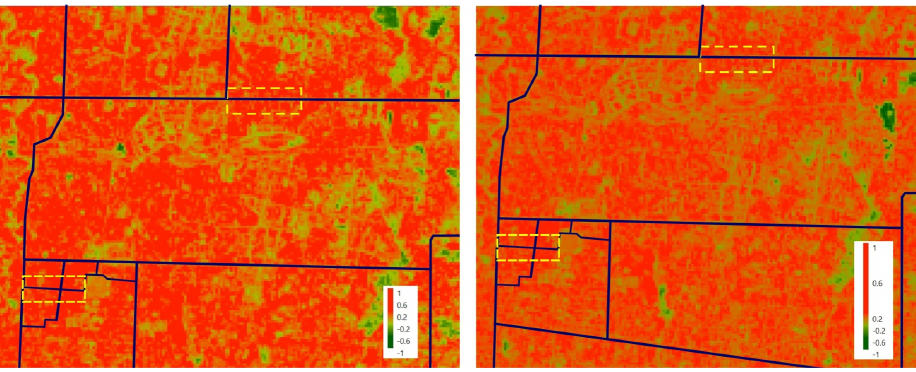
Fig. 10. NDBI maps retrieved from Landsat-8 OLI TIRS on May 5 at 02:47:15 (left) and August 25 at 21:50:13